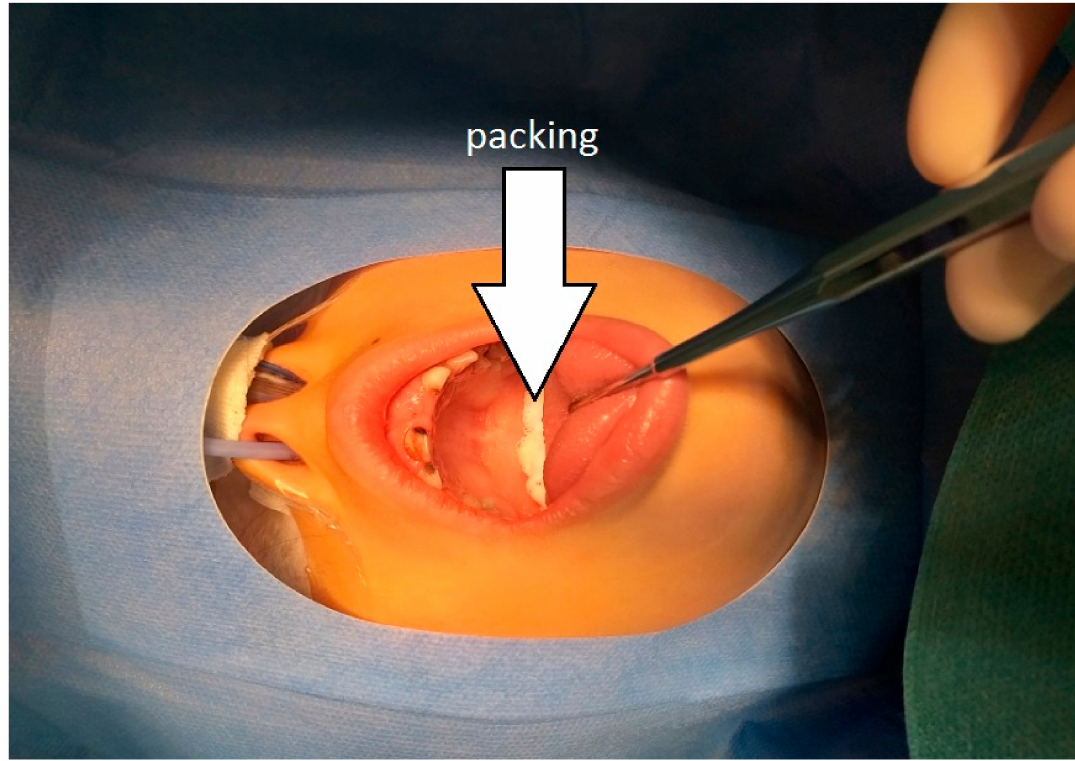
Figure 2. Pharyngeal packing in a child under general anesthesia